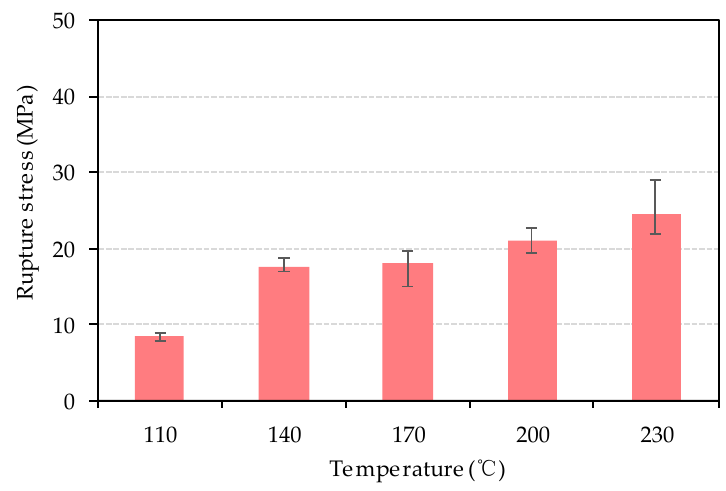
Figure 9. Tensile rupture stress of bio-board at di ff erent temperature ( p < 0.05).